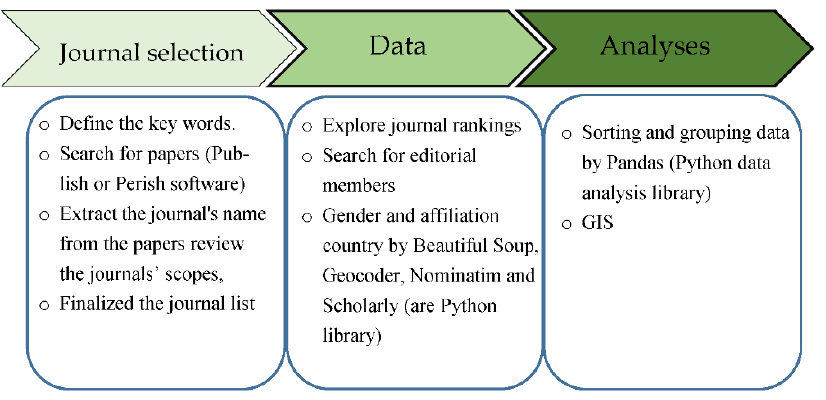
Figure 1. Research Methodology Flowchart. The first stage was the identification of the journals; the second was the data collection; and finally, a group of methods for data analysis was chosen.